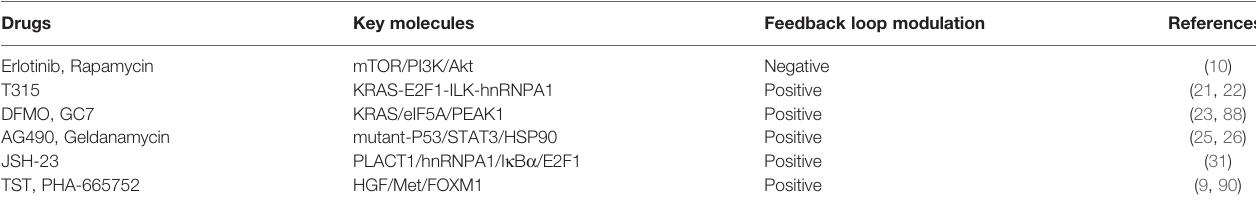
TABLE 2 | Intervened feedback loops and treatments in pancreatic cancer. Drugs Key molecules Feedback loop